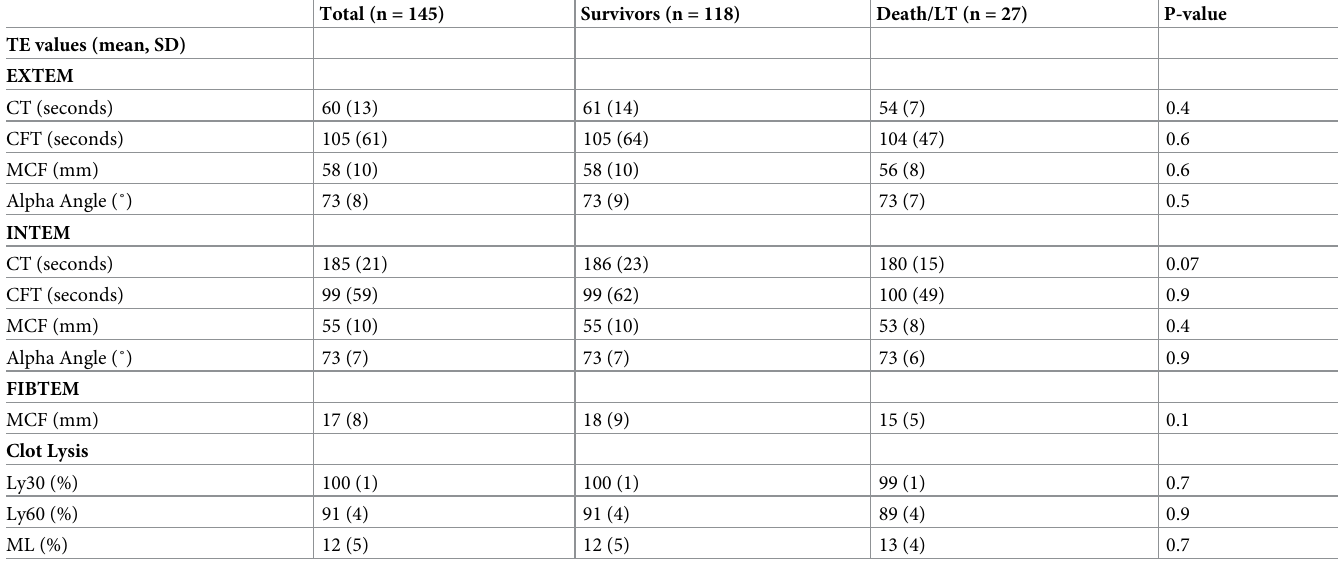
Table 2. Thromboelastometry test